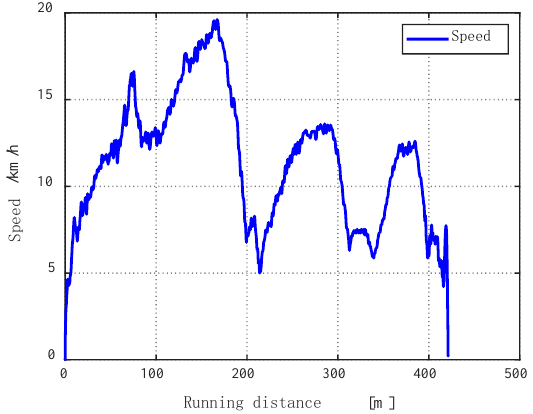
Figure 11. Vehicle speed.